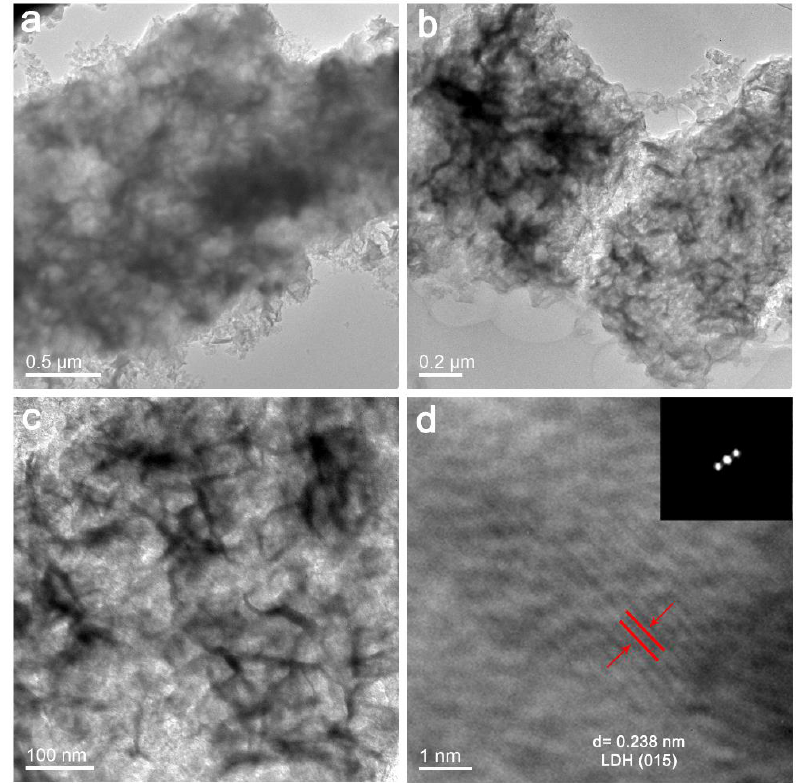
Figure 4. (a–c) TEM and (d) HRTEM images of NiFe LDHs/CB-TC, inset in ( d ) is the FFT (Fast Figure 4. ( a – c ) TEM and ( d ) HRTEM images of NiFe LDHs / CB-TC, inset in ( d ) is the FFT (Fast Fourier Fourier Transform) pattern. Transform)